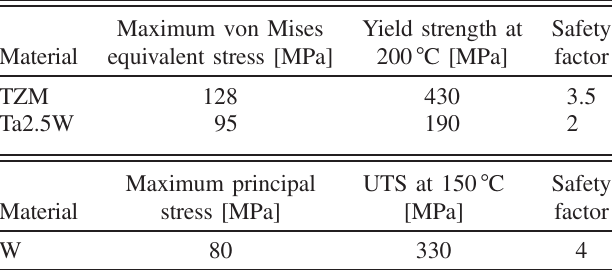
TABLE IV. Maximum stresses reached in the BDF target materials and safety factor with respect to the material limits reported in literature [28,29,32].